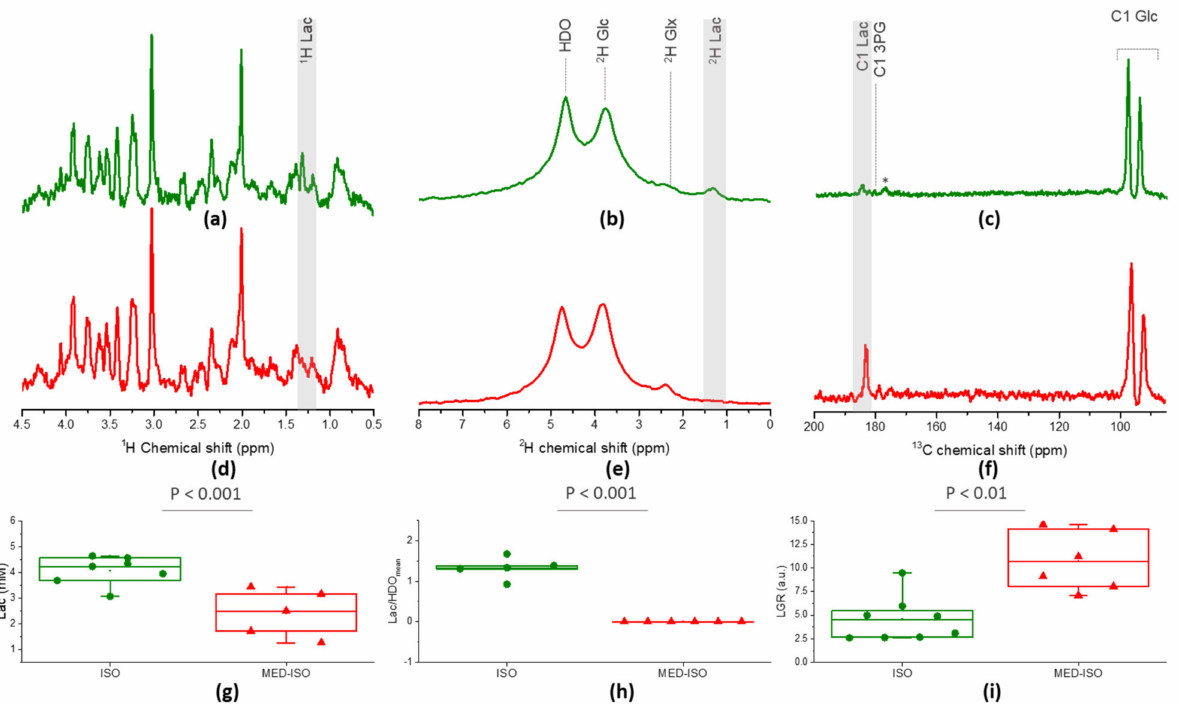
Figure 1. Typical summed spectra measured with 1 H MRS ( a , d ), 2 H MRS ( b , e ) and HP 13 C MRS ( c , f ) under isoflurane solely (‘ISO’, in green) and under medetomidine combined with isoflurane anesthesia (‘MED–ISO’, in red). In ( c , f ), the glycolytic intermediate 3-phosphoglycerate (3PG, 179.8 ppm) can be identified in the summed spectra in addition to the C1-Lac at 183.5 ppm. The broad peak at 175 ppm designated by (*) is an impurity in the HP [ 2 H 7 , U- 13 C 6 ] Glc powder. Significant differences between the two anesthesia groups are found in endogenous Lac concentration measured by 1 H MRS ( g ), in lactate/HDO mean measured by 2 H MRS ( h ), and in Lac-to-Glc ratio (LGR) measured by HP 13 C MRS ( i